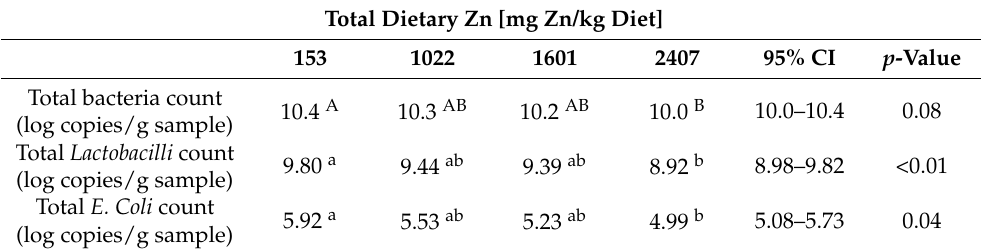
Table 6. The number of total bacteria, total Lactobacilli and total E. Coli in faeces at day 21 post- weaning (log copies/g sample, N = 20 pigs/dietary